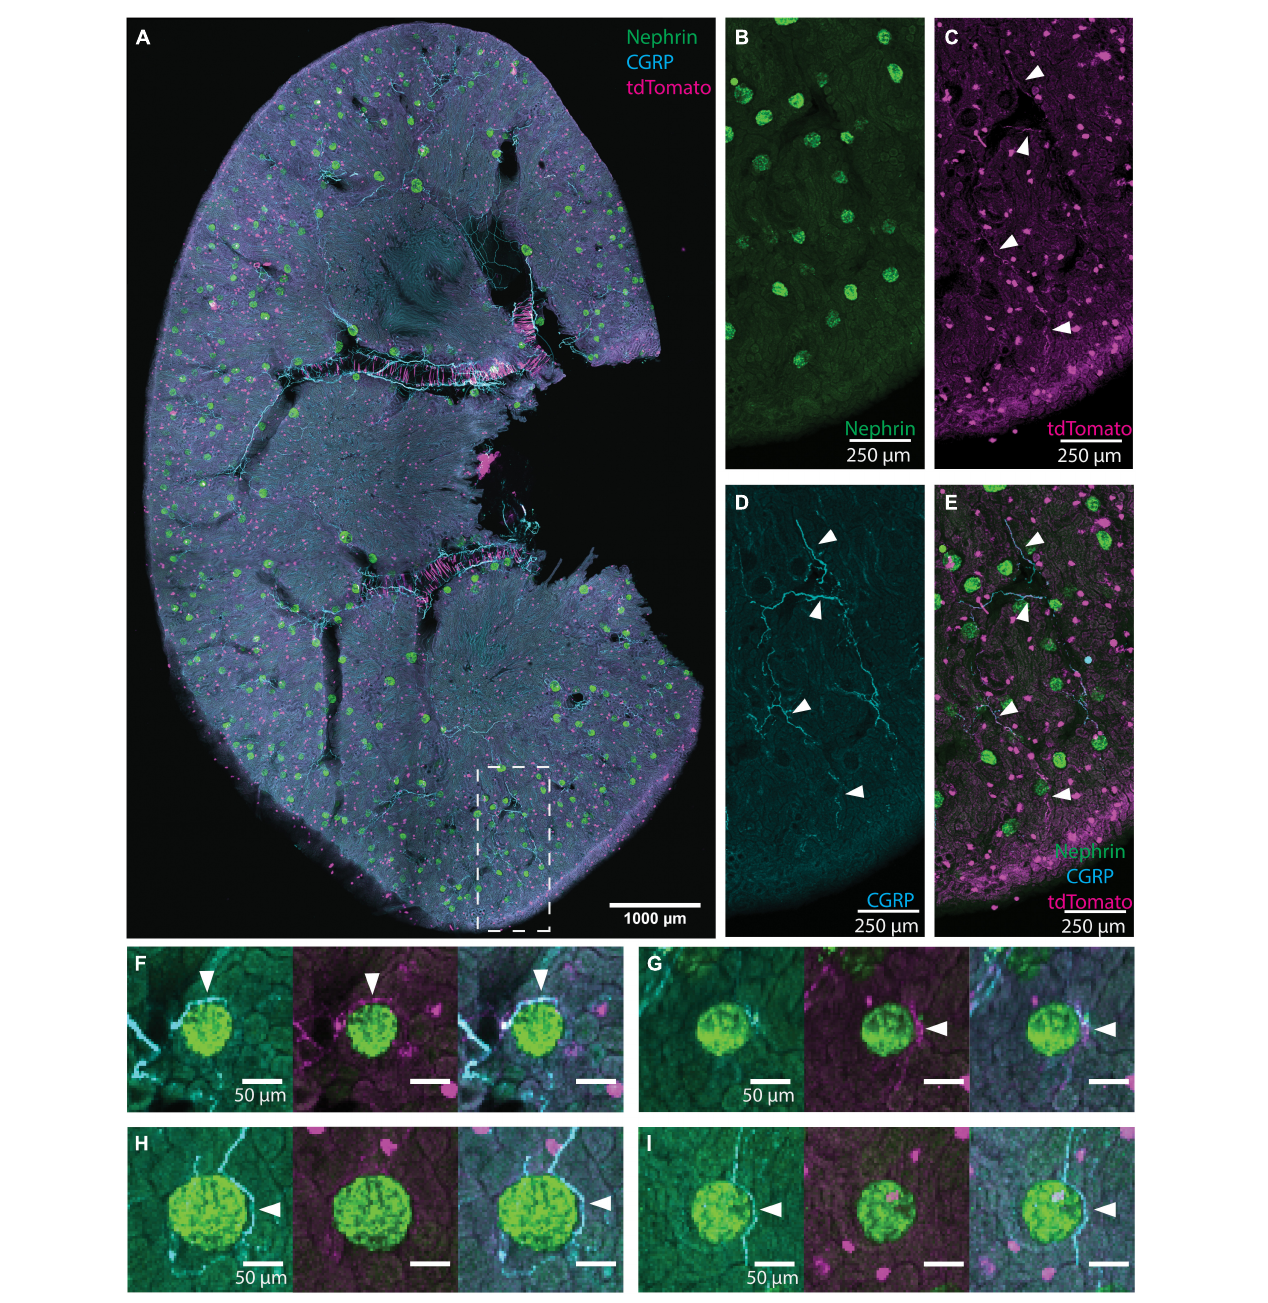
FIGURE1 Illustration of glomerular scoring. (A) An image of native tdTomato fluorescence (magenta, tdTomato+ axons) and immunolabeling for nephrin (green, glomeruli) and calcitonin gene related peptide (CGRP) (cyan, peptidergic axons) in a renal slice from a TRPV1:Ai14 mouse. The image represents a maximum intensity projection of 6 optical sections collected 13.7 microns apart. While this image includes CGRP+ and tdTomato+ labeling for illustrative purposes, only images immunolabeled for one neuronal marker at a time were used during glomerular scoring. (B–E) A magnified inset from panel (A) illustrating the labeling of glomeruli and axons in the renal cortex (scale bars: 250 µ m). (B) Nephrin+ labeling of glomerular podocytes. (C) Native tdTomato fluorescence. Examples of labeled axons are highlighted with arrowheads. The identity of globular cell-like profiles is unknown. They appeared to be associated with tubules and were not co-labeled with a pan-immune cell marker (anti-CD45, data not shown). They were clearly distinguished from axonal profiles and, therefore, did not affect the glomerular scoring. (D) CGRP+ labeling of afferent axons (some highlighted with arrowheads). (E) Composite image illustrating CGRP labeling and tdTomato fluorescence in afferent axons (some highlighted with arrowheads) in the renal cortex. (F–I) Examples of anatomical relationships between axons and glomeruli as observed while scoring individual glomeruli (scale bars: 50 µ m). (F) Both CGRP+ and tdTomato+ axons (arrowheads) approach the glomerulus. (G) A tdTomato+ axon bundle (arrowhead) approaches the glomerulus, and although the cyan channel exhibits some labeling, its morphology is not consistent with the appearance of axons and is therefore not scored as an anatomical interaction between CGRP+ axons and the glomerulus. (H) A clear anatomical relationship between a CGRP+ axon bundle (arrowhead) and the glomerulus. Although there is faint labeling in the magenta channel, the signal to noise ratio is not high enough to count as a close apposition. (I) CGRP+ axon (arrowhead) surrounds the glomerulus extend beyond it. Scale bars: (A) 1000 µ m, (B–E) 250 µ m, (F–I) 50 µ